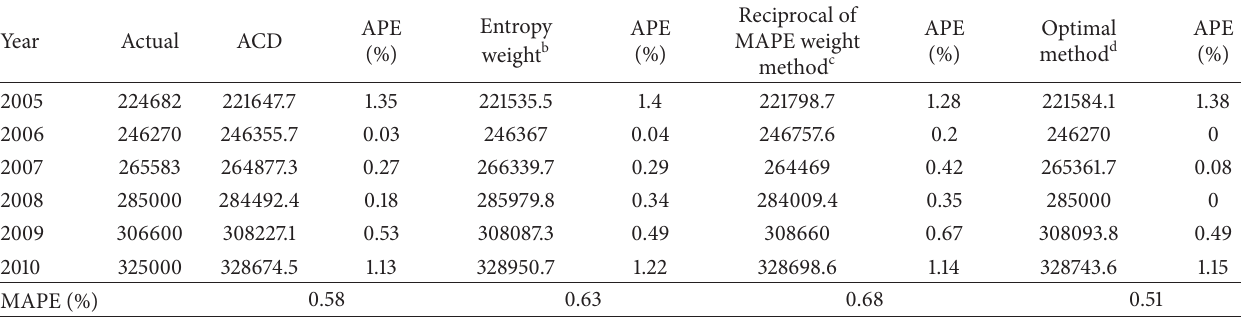
Table 4: Forecasting results of China’s energy consumption by combination models based on different weights assignment methods in 2005 ∼ 2010.